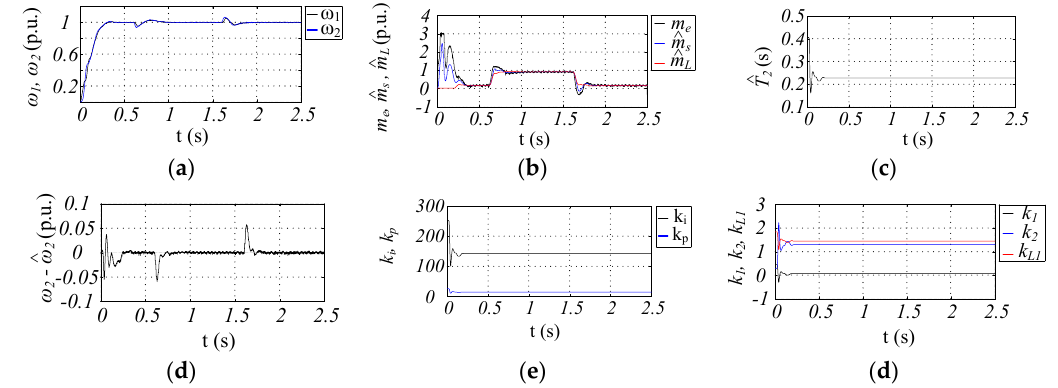
Figure 6. Transients process of the adaptive control structure with the UKF estimator – the experimental results: the motor and load angular speed ( a ), the electromagnetic, shaft and load torques ( b ), the estimated value of the load time-constant of the machine ( c ), the load speed estimation error ( d ), the control structure coefficients ( e , f ) for the rated value of the reference speed signal